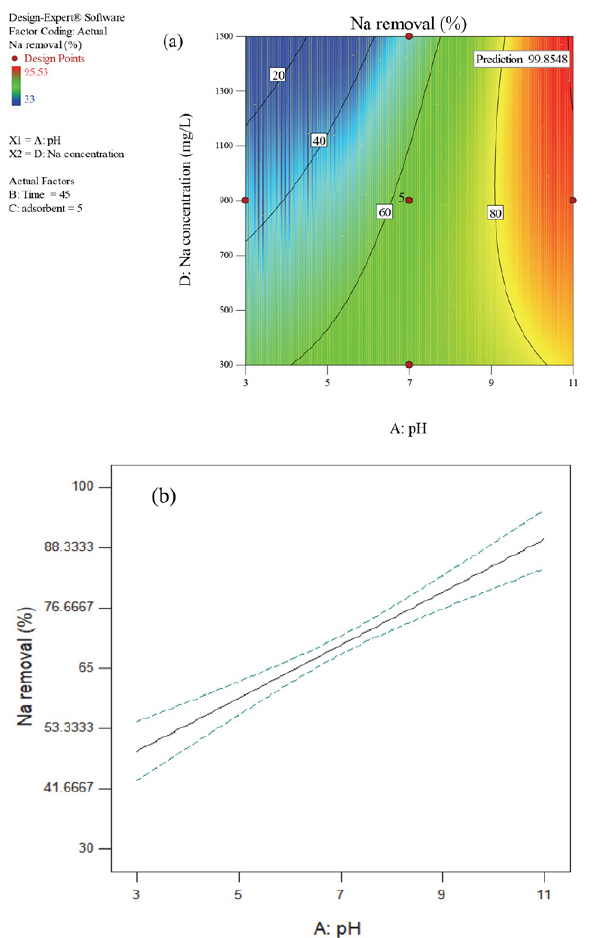
Figure 5. The effect of contact time on sodium adsorption from aqueous solution using the AC in different sodium ion concentra- tions